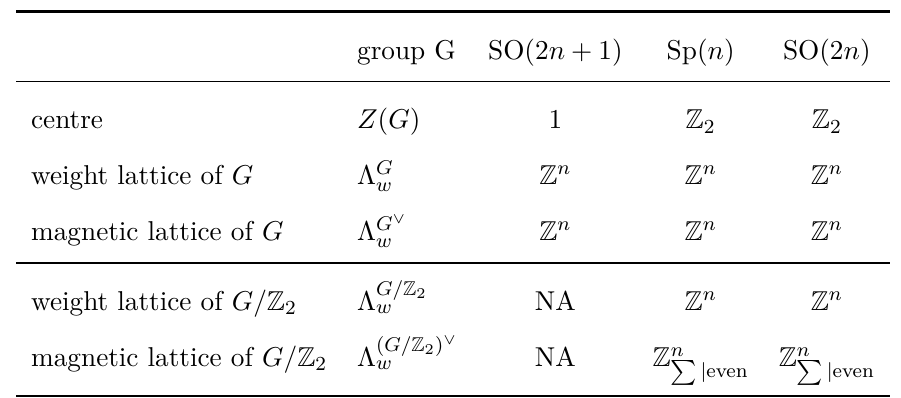
Table 1. Lattices associated to different gauge group factors. Z ( G ) denotes the centre of a group stands for the weight lattice of the group G , while Λ G ∨ is the magnetic lattice of G — also G . Λ G w w known as weight lattice of the GNO dual group G ∨ [57]. Z n denotes the standard integer lattice in n dimensions. Z n P stands for the set of points ( a ) ∈ Z n such that P a i = even . 1 , . . . , a n i | even Likewise, Z n P denotes the points ( a ) ∈ Z n such that P a i = odd 1 , . . . , a n i | odd